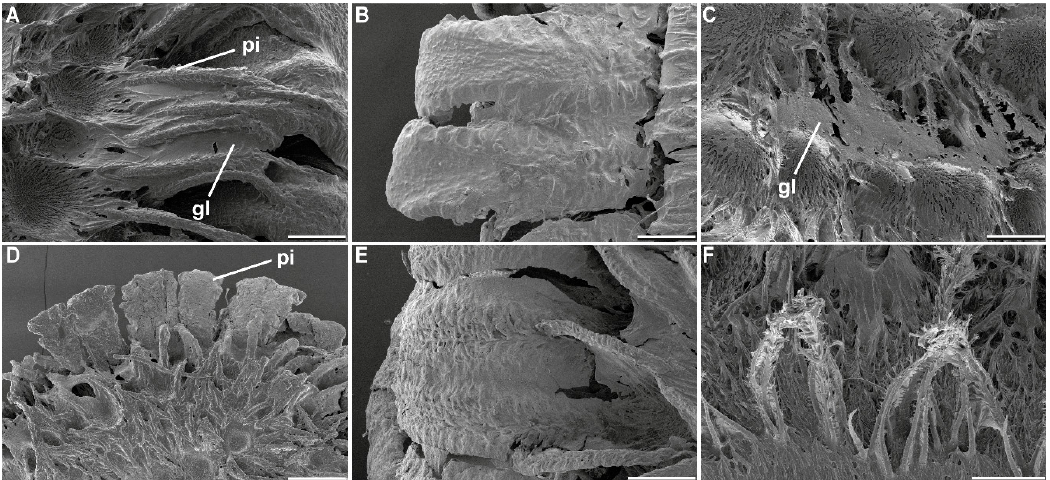
Figure 5. Scanning electron micrographs of the glue morphology after exposition to different solvents: ( A ) Propan-2-ol treated, no response of the glue; ( B , D , E ) Treatment with high and low pH solutions, denaturation: ( B ) pH 5.0, ( D ) pH 10.9, ( E ) pH 13.9; ( C ) Chloroform, glue solved from the egg surface, but large amounts kept between the pinnae; ( F ) Acetone, glue solved from the most of the egg surface, but residuals kept on the pinnae; pi, pinna; gl, glue; Scale bars: 500 μ m ( D ), 200 μ m ( A – C , E ), 100 μ m ( F ).